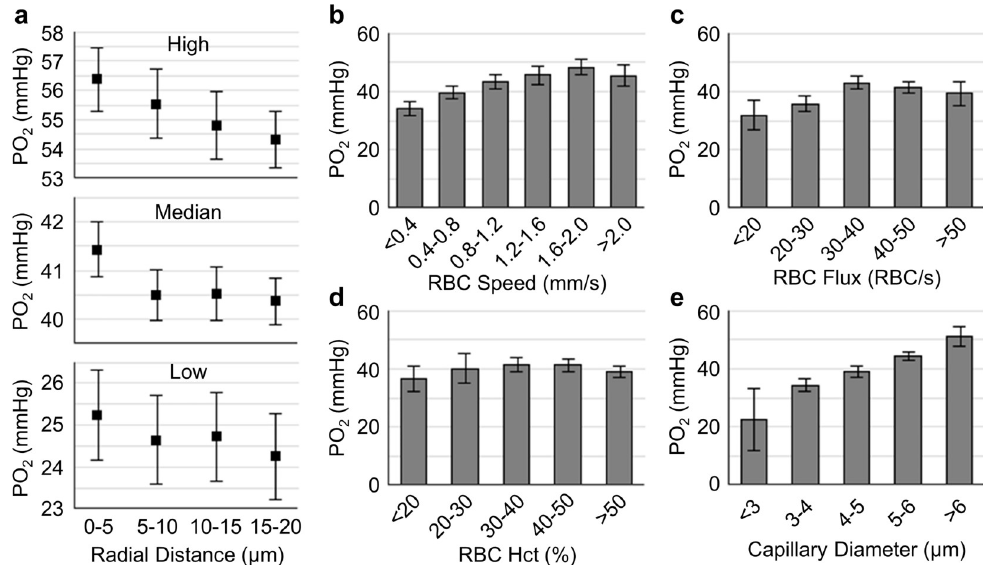
Fig 2. Relations between capillary RBC flow properties, diameters, wall PO 2 , and adjacent tissue PO 2 gradients. a. Average tissue PO 2 gradients from high, medium and low wall PO 2 capillary groups, collected across n = 12 mice. b - e. Relations between RBC speed, flux, hematocrit (Hct), diameter and wall PO 2 . The analysis in b - e was made with the measurements acquired in ~15 capillaries per mouse across n = 12 mice (including both the young and old mice). Data are expressed as mean ± SEM.